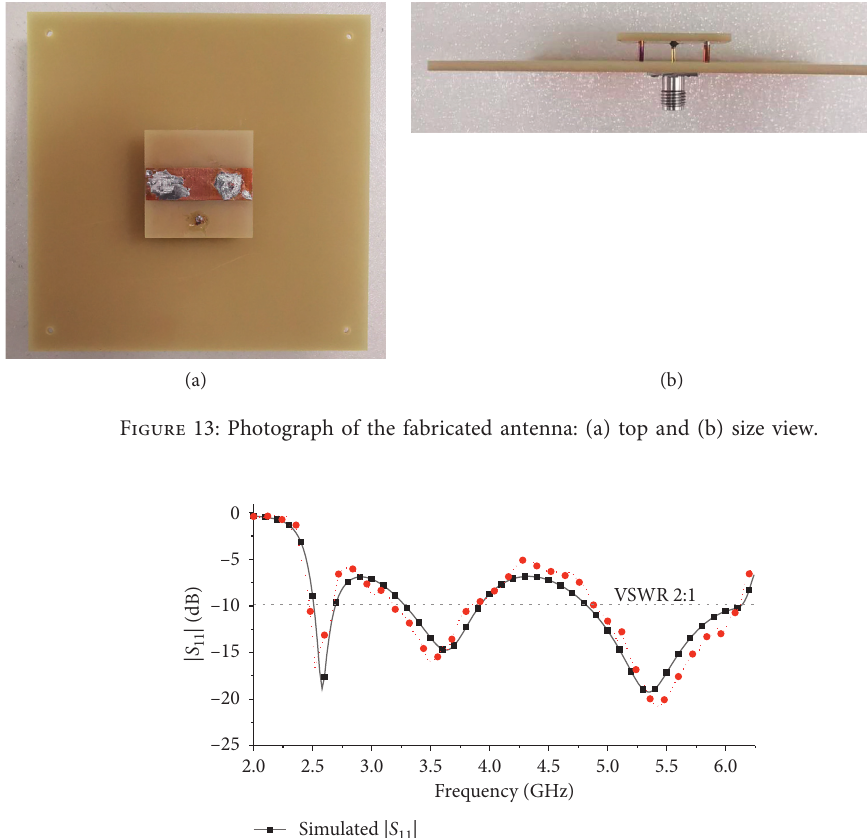
Figure 12: 3D radiation patterns of the proposed antenna: (a) f � 2.6GHz; F (d) f � 5.3 GHz; F y � 8mm.